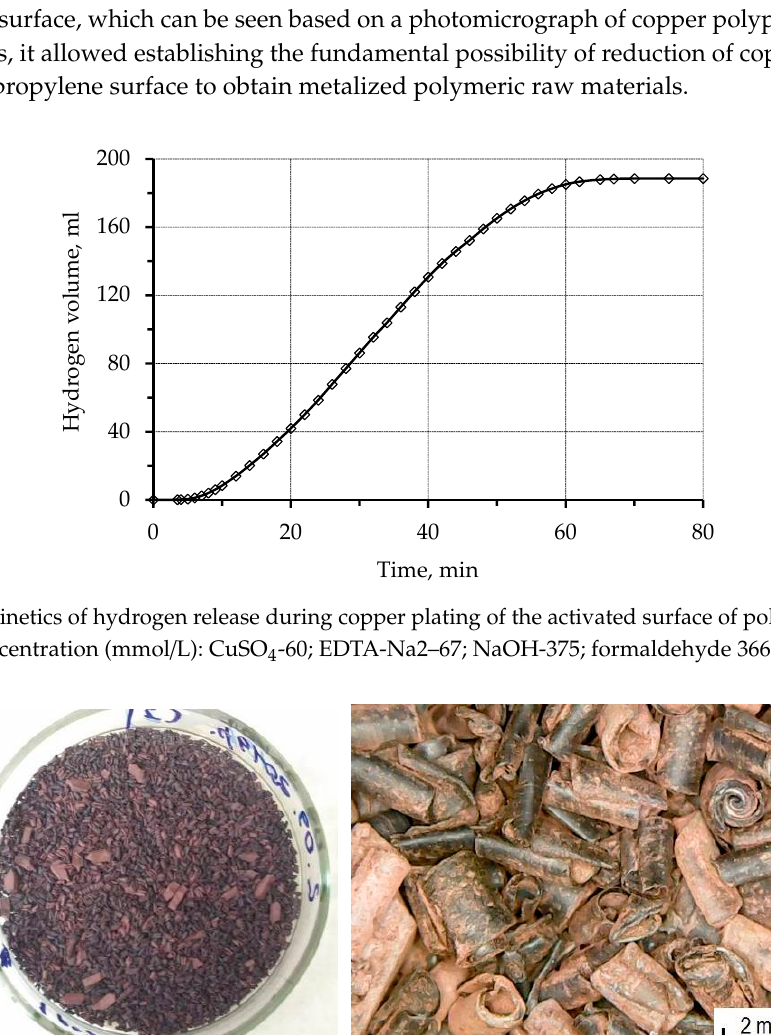
Figure 4. Photomicrographs of copper polypropylene waste.